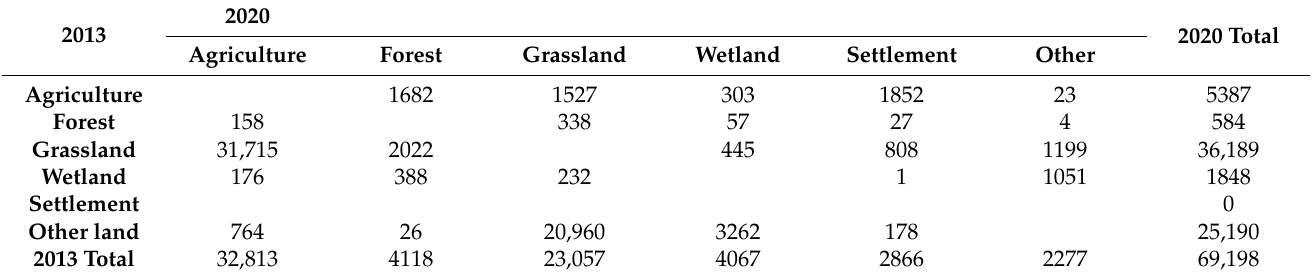
Table 5. LUCC conversion matrix in the CANs from 2013 to 2020 (unit: km 2 ).